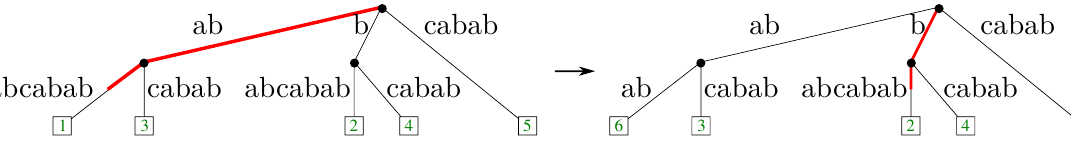
Figure 4. Shifting the window ababcabab to the right for one character, where B = abab denoted by red labels. Notice the “lost” leaf abab on the right, where instead of removing the oldest leaf, we only update its position. For brevity, the figure omits the newly appended character to the window. To find a new β and an edge corresponding to the updated B , we simply follow the suffix link of the β ’s parent and navigate the remainder of B from the obtained